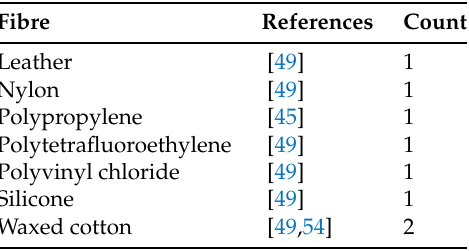
Table 4. Frequency of various fibre